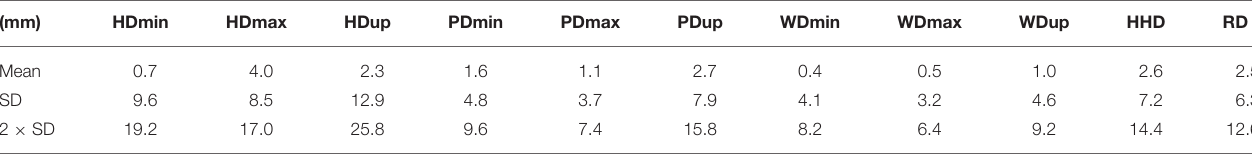
TABLE 3 | Limits of agreement [19] between straight-line and matching average-rein asymmetry values from N = 79 gait assessments in 26 horses. (mm) HDmin HDmax HDup PDmin PDmax PDup WDmin WDmax WDup HHD RD Mean 0.7 4.0 SD 2 × SD